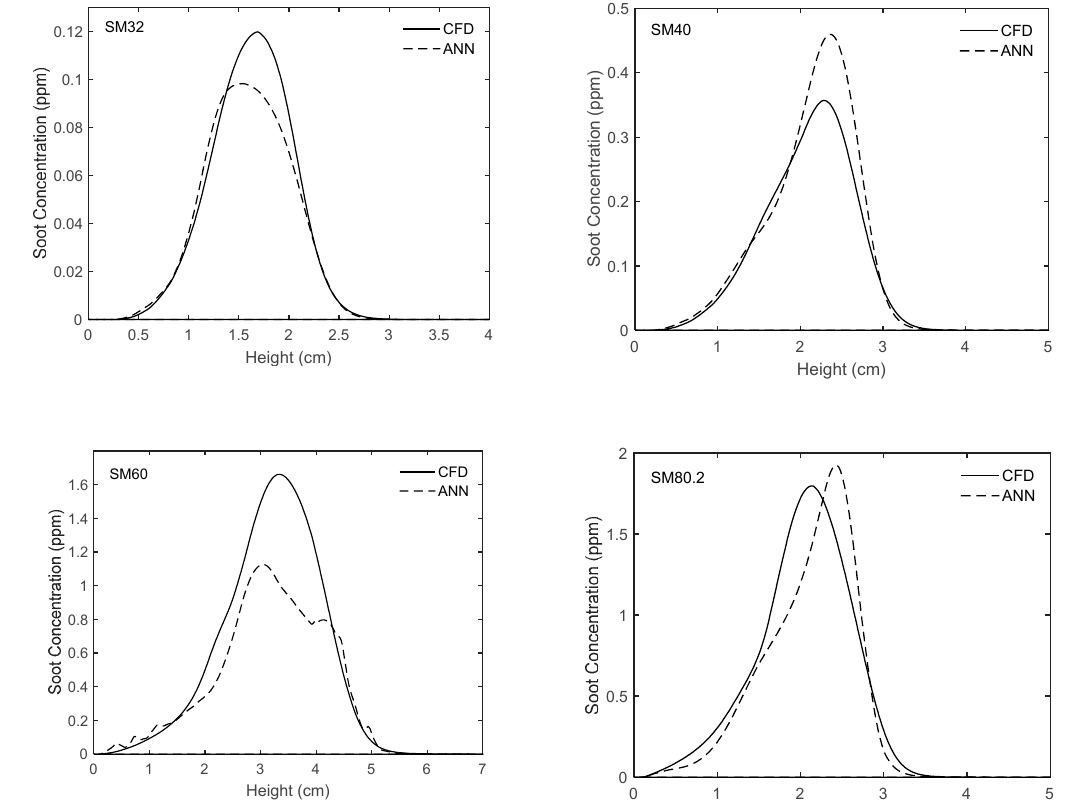
Figure 11. Comparison of experimentally-validated CFD results and those obtained from the ANN for different flames along the streamline of maximum soot.